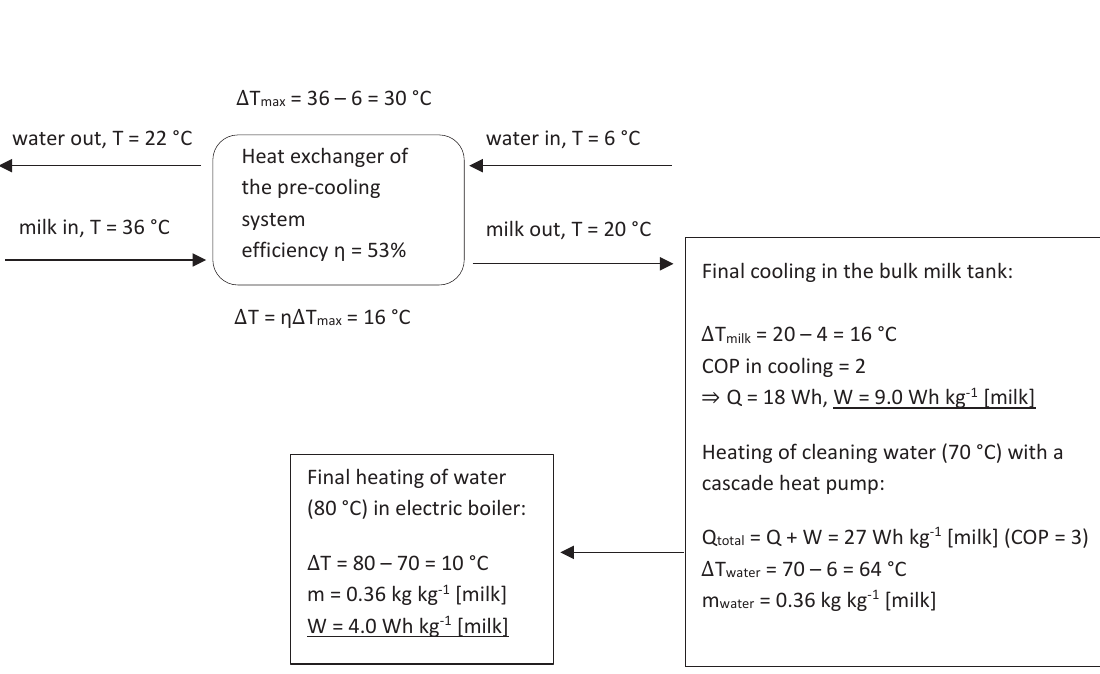
Fig. 7. Scheme of combined milk cooling and water heating system with partial pre-cooling of milk and heat recovery from the final cooling for heating the cleaning water with a cascade heat pump. System could produce ca. one third of hot water of the milk amount produced with total electricity consumption of ca. 14 Wh per one kilogram of